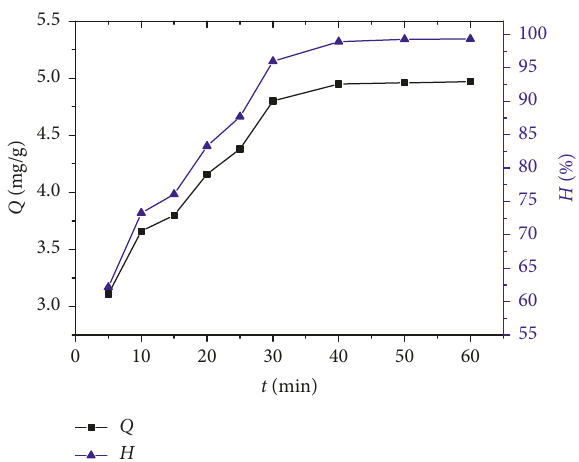
Figure 11: The effect of HAp granules mass on the adsorption 6g/L; capacity and the removal efficiency of Pb 2 + ( C 0 (cid:31) t contact 40min; T 30 ° C). (cid:31) (cid:31)